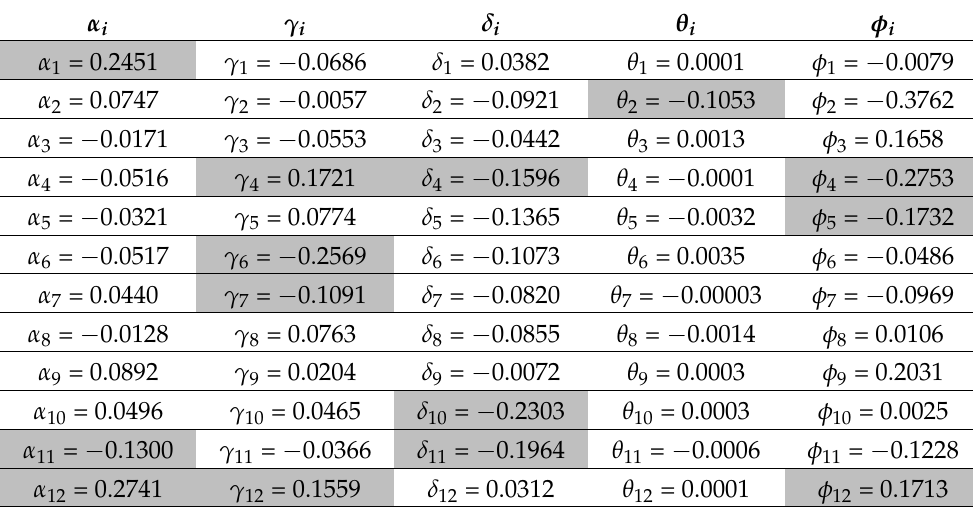
Table 6. Estimated coefficients from Ridge Regression model.